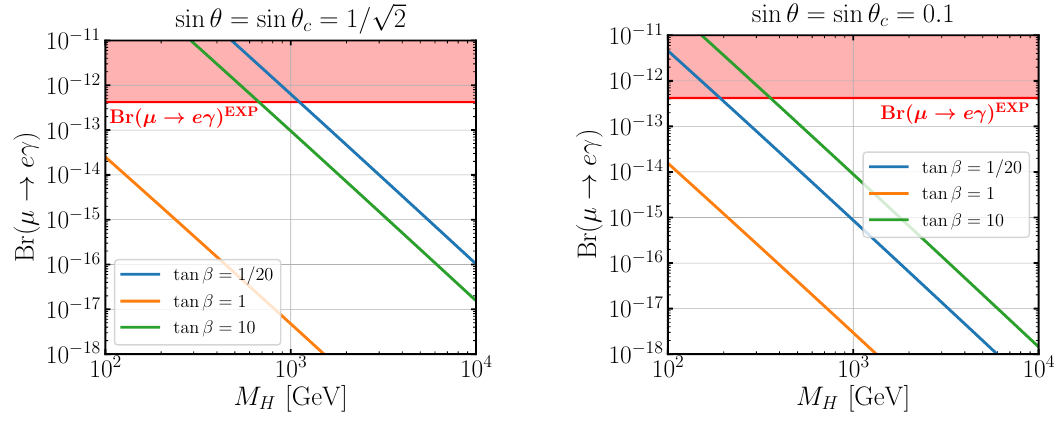
Figure 9 . Branching ratio for the process µ → eγ as a function of the mass of the Higgs bosons M H = M A . The region shaded in red corresponds to the experimental upper bound on this branching ratio. For the left (right) panel we fix the mixing angles to sin θ = sin θ ( sin θ = sin θ = 0 . 1 ). c